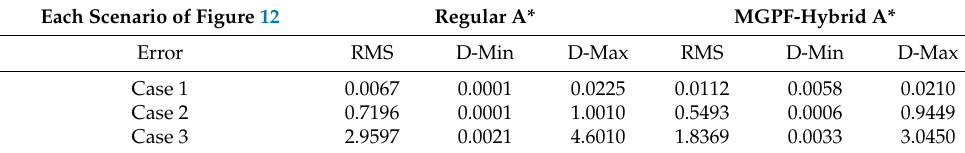
Table 1. Performance measures of A* and MGPF-Hybrid A*.